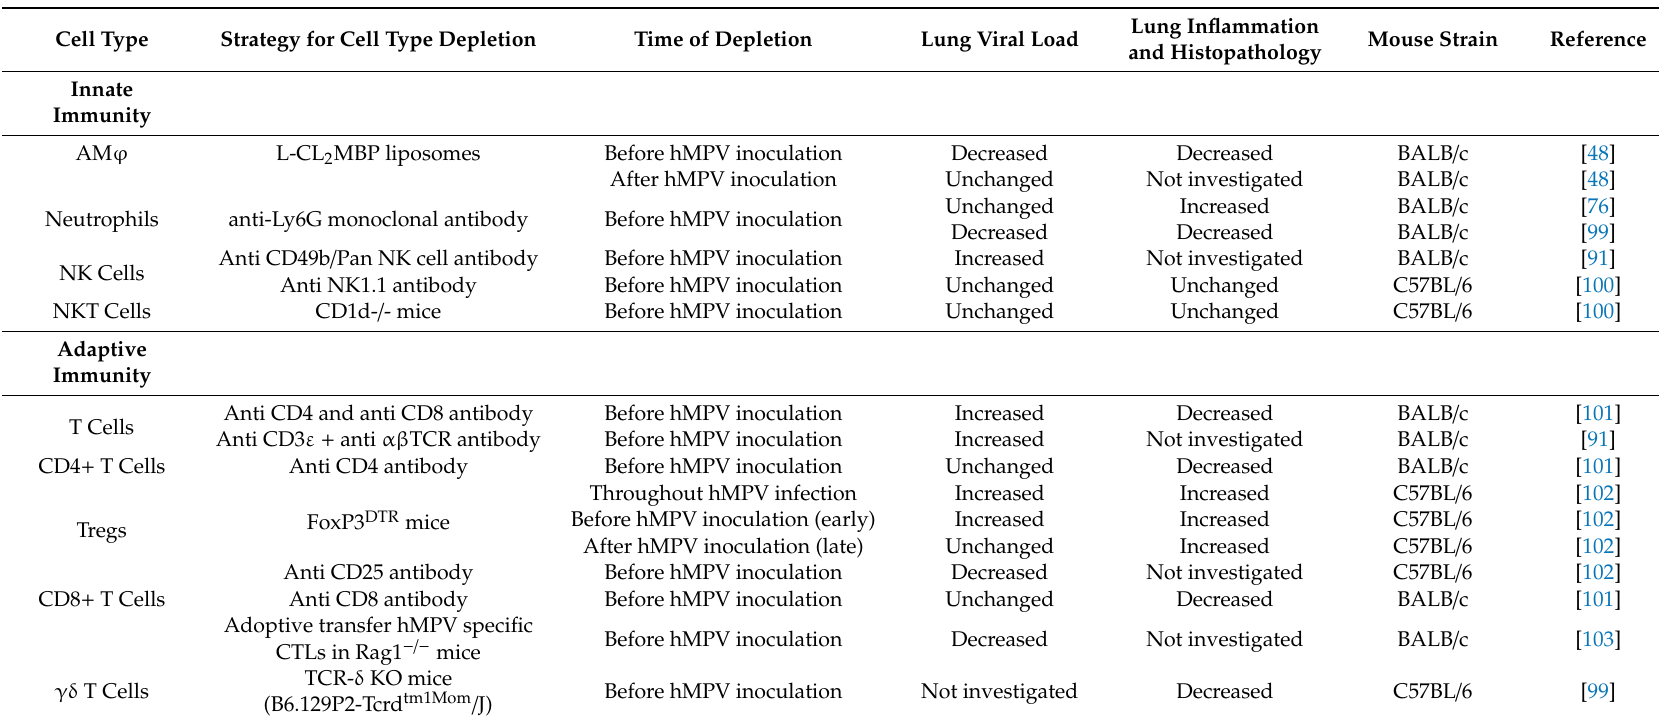
Table 1. Studies showing the importance of di ff erent cell types involved in hMPV